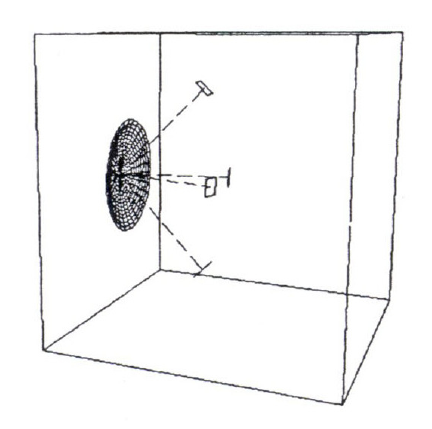
Figure 1. Multi station convergent network (Mason, 1995)